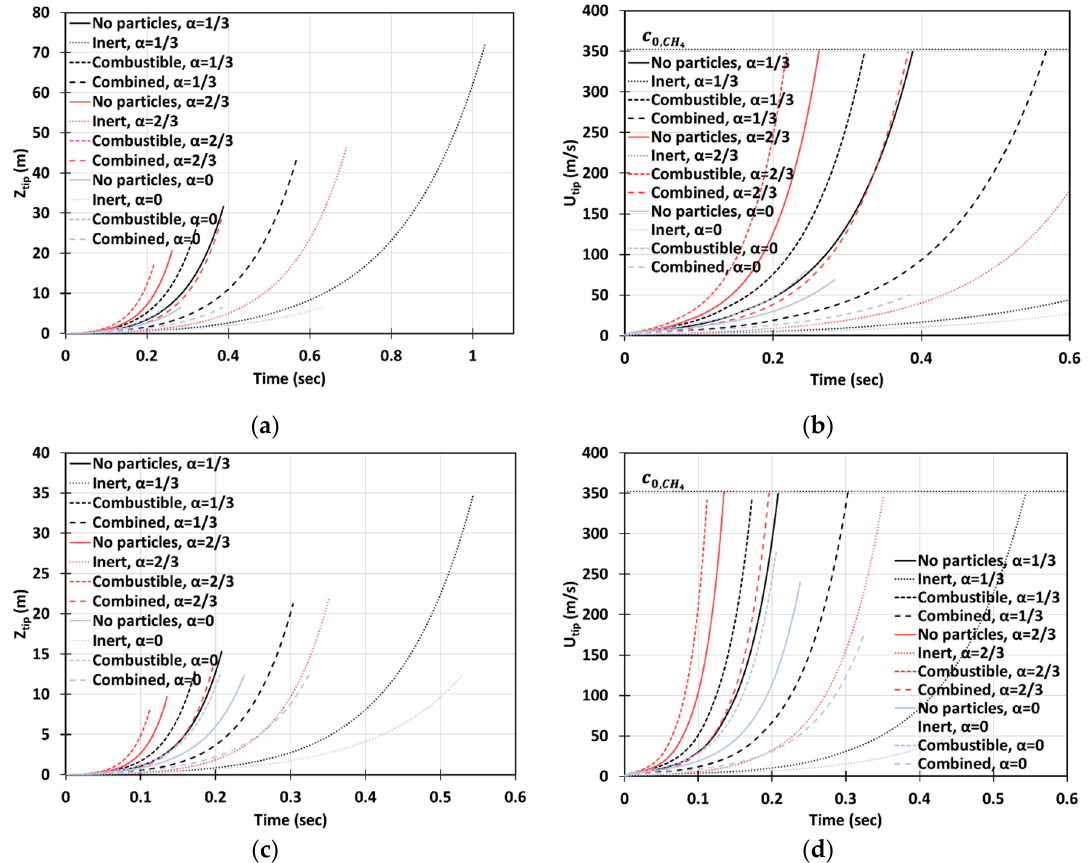
Figure 15. Time evolution of the flame tip position Z tip ( a , c ) and velocity U tip ( b , d ) in a 2D ( a , b ) and cylindrical-axisymmetric ( c , d ) geometries for lean CH 4 -air burning of φ = 0.7, without and with dust particles (combustible, inert, and combined) of particle radius r s = 75 µ m and concentration c s = 250 g/m 3 , for various blockage ratios, α =